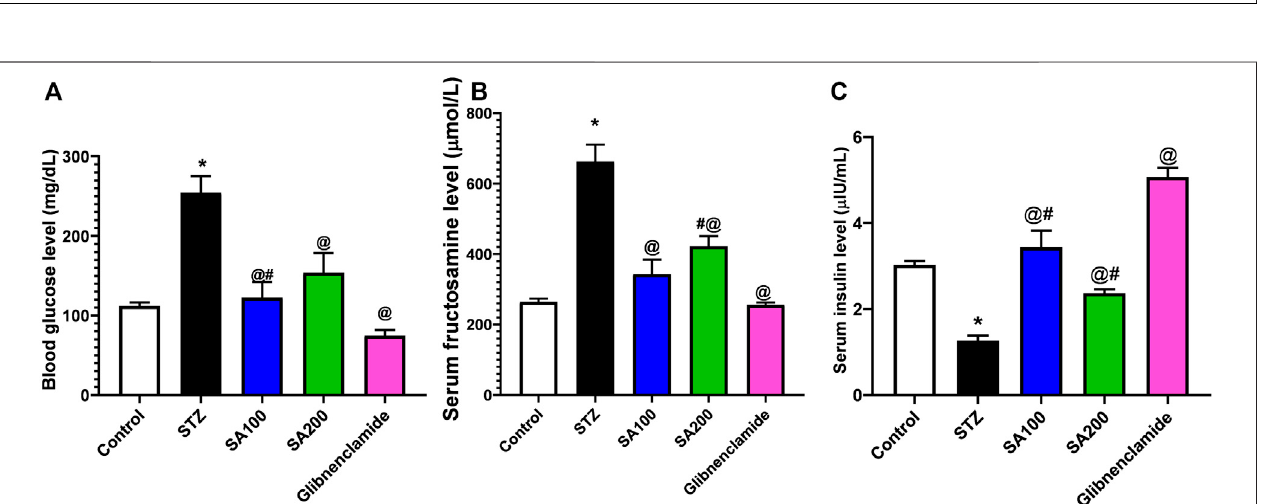
Frontiers in Pharmacology |